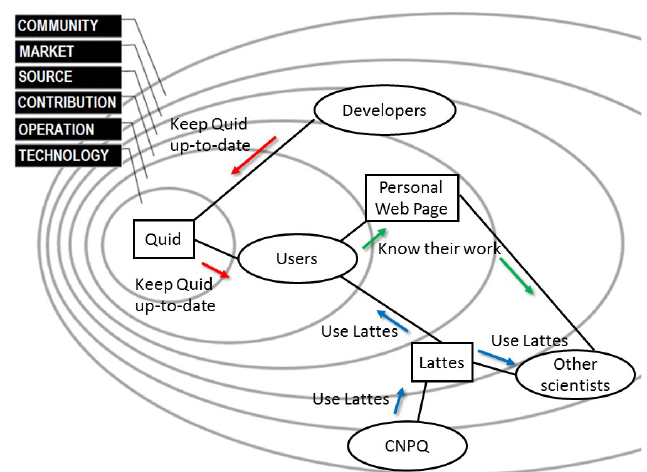
Fig. 22. Proposed stakeholder diagram, encompassing human and non-human actors.